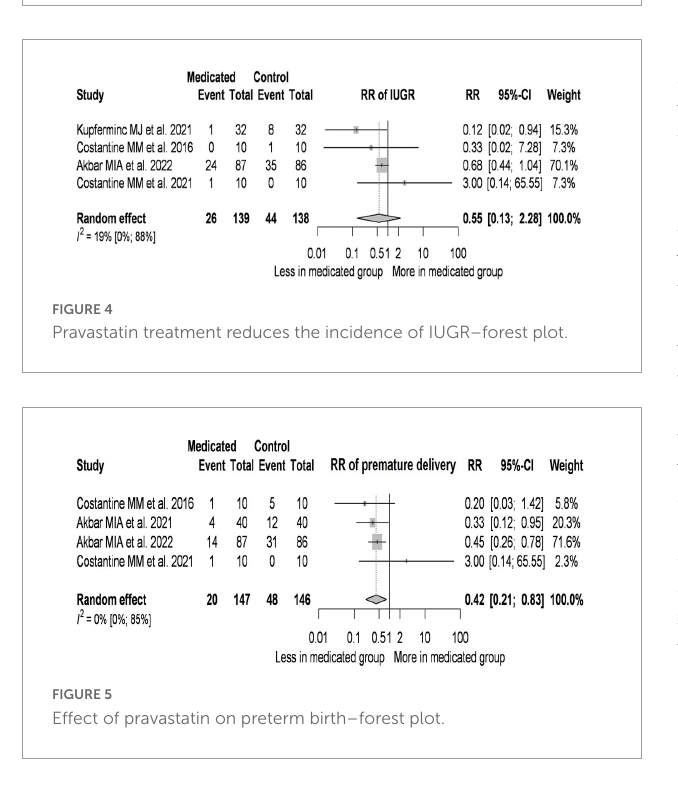
FIGURE3 Effect of pravastatin treatment on the prevention of preeclampsia–forest plot.